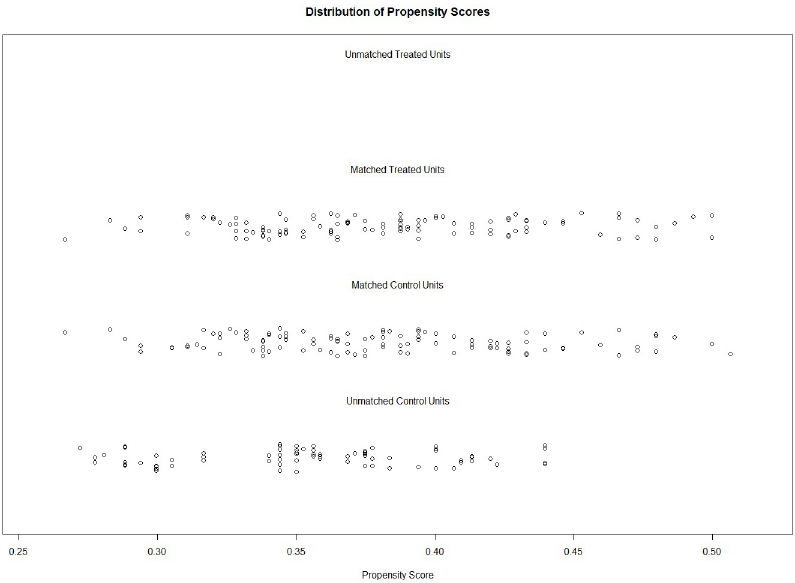
Fig 7. Propensity score distribution in Analysis 1b for the overlap between the 2002 sample and the 2020 sample. Unmatched units were discarded after the matching procedure to ensure an optimal overlap in propensity scores of the two groups.